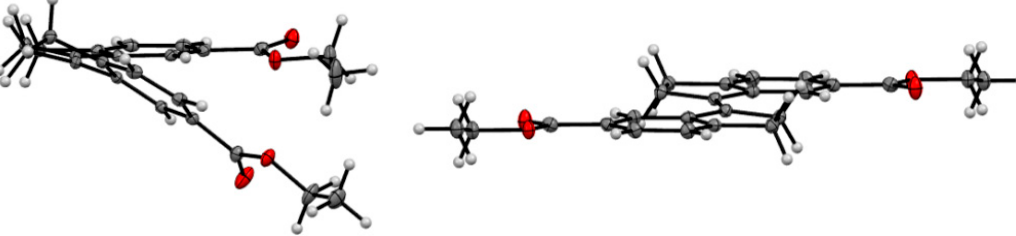
Figure 5. ORTEP view of Z - 16 ( left ) and E - 16 ( right ). Thermal ellipsoids are drawn at the 35% probability level.